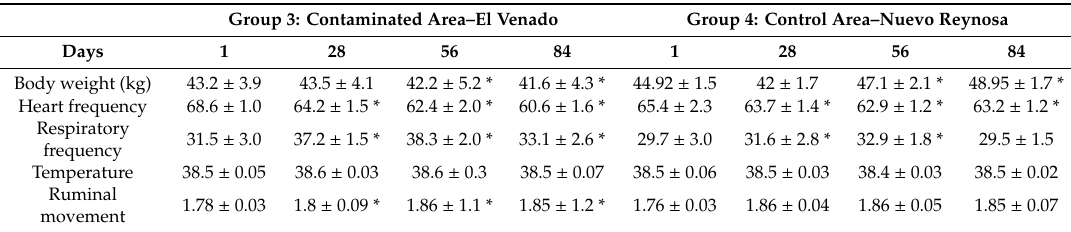
Table 5. E ff ects of arsenic on physiological conditions in female Creole goats in a contaminated zone and control area (Groups 3 vs.